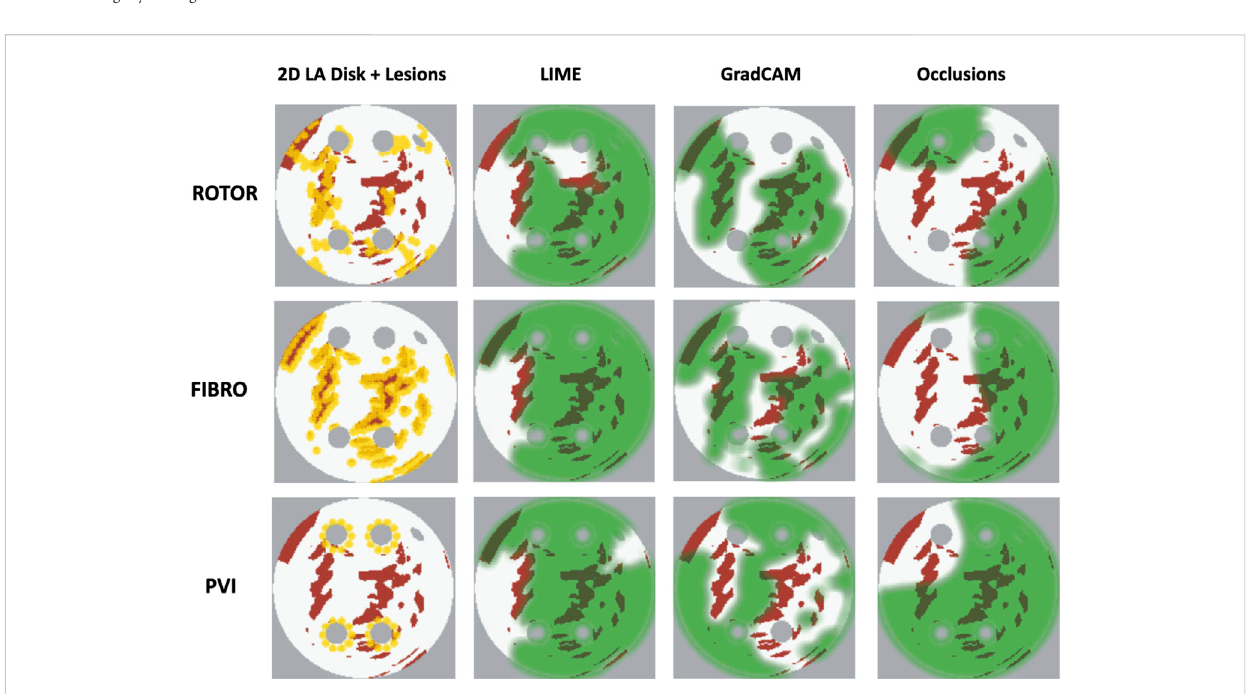
FIGURE 3 Diagramof2DLAtissueswithhighlightedfeatureattributionmaps.Whiteareasinthe2Dtissuesarehealthytissueandredareasare fi brosis.Ablation